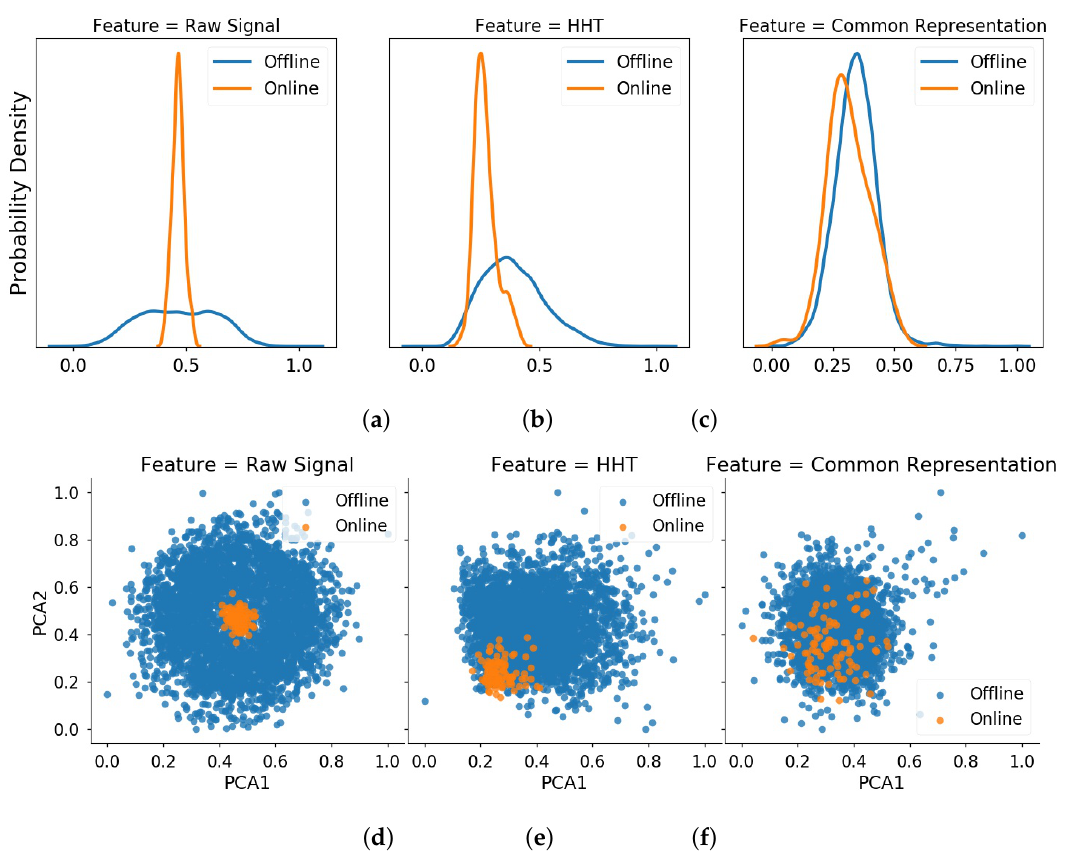
Figure 13. Comparative distribution of Target 2 and nine training bearings, with ( a – c ) the probability density distribution of raw time signal, HHT marginal spectrum, the common deep features by domain adaptation DAE, and ( d – f ) the feature distribution corresponding to ( a )–( c ), respectively. Please note that the legend “Online” denotes the distribution of the target bearing (Target 2) and “Offline” denotes the distribution of nine training bearings. (similar to Figures 10 and 11).